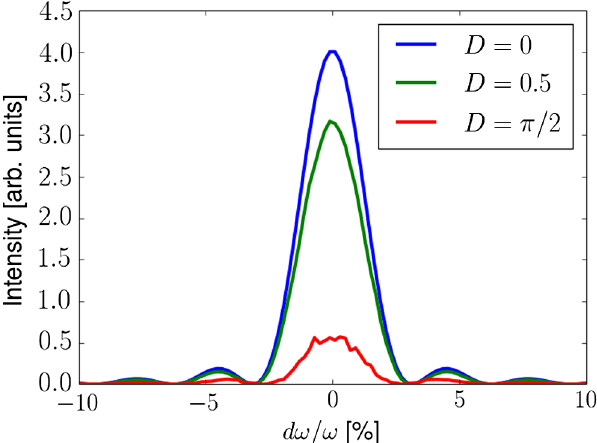
5. Spectrum corresponding to various diffusion dephasing parameters, averaged over 1000 realizations. N w ¼ 100